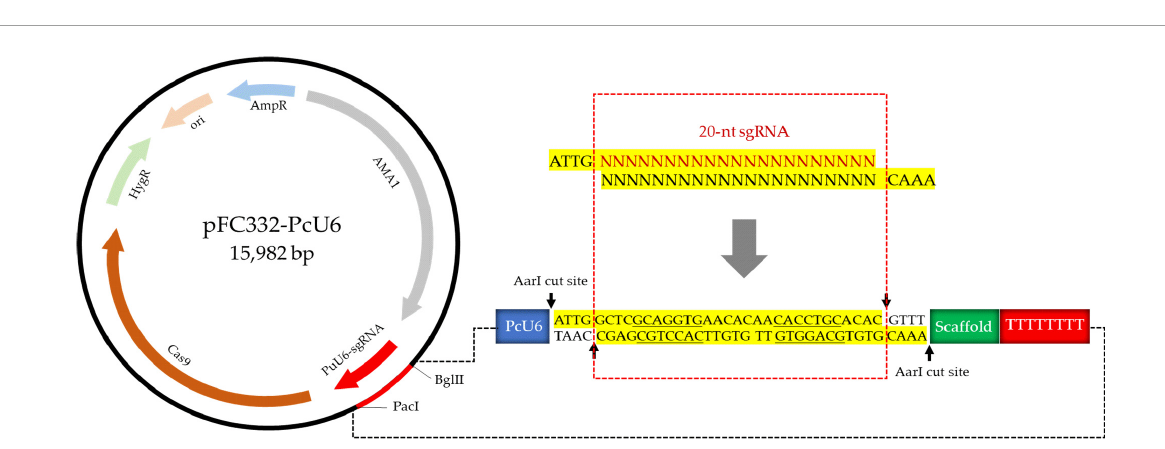
preparation process, it was observed step by step with the microscope (MSD 105, Guangdong, China) with 400 times magnification to confirm the release of protoplast from